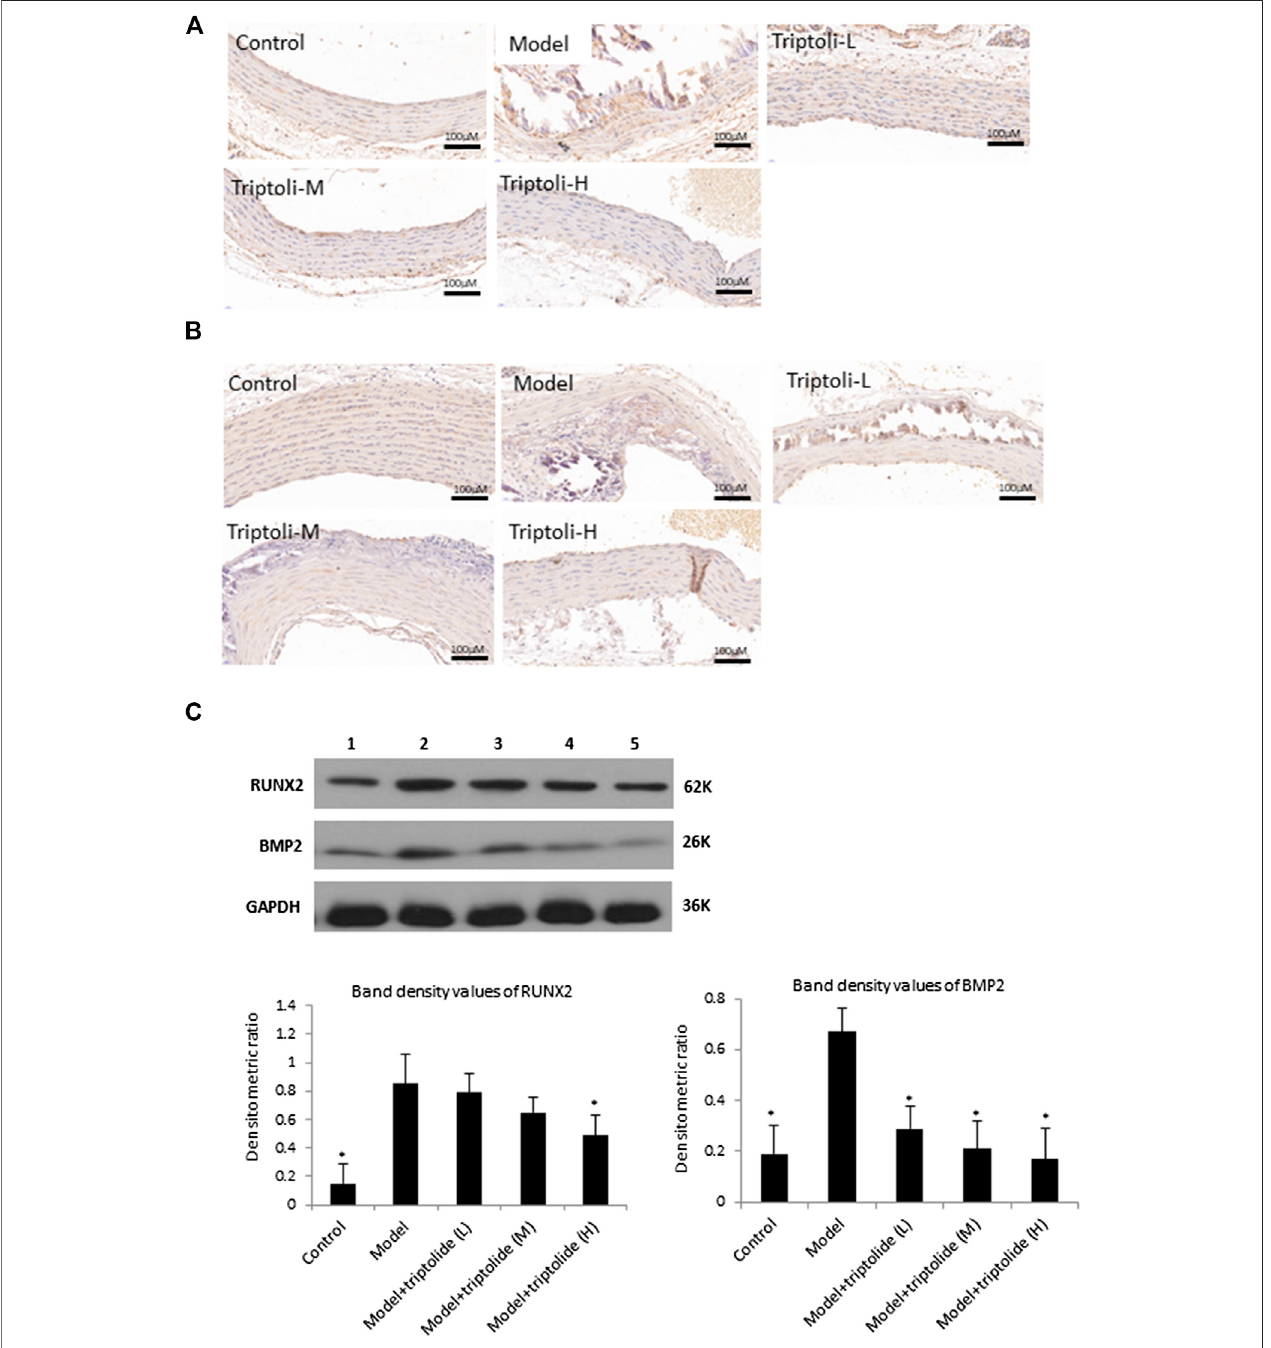
FIGURE 2 | TP suppresses BMP2 and RUNX2 expression induced by vascular calici fi cation to the aortas (A) Immunohistochemical staining of BMP2 (B) ImmunohistochemicalstainingofRUNX2 (C) WesternblotanalysisofBMP2andRUNX2(lane1:Control,lane2:Model,lane3:Model+TP-L,lane4:Model+TP-M,lane 5: Model + TP-H. Upper: representative images of BMP2 and RUNX2 expression, an antibody for DAPDH was used to show equal protein loading; under: bar graphs show quantitative evaluation of BMP2 and RUNX2 expression (n (cid:2) 3). Data are reported as mean ± S.D, * p < 0.05 compared with model group.